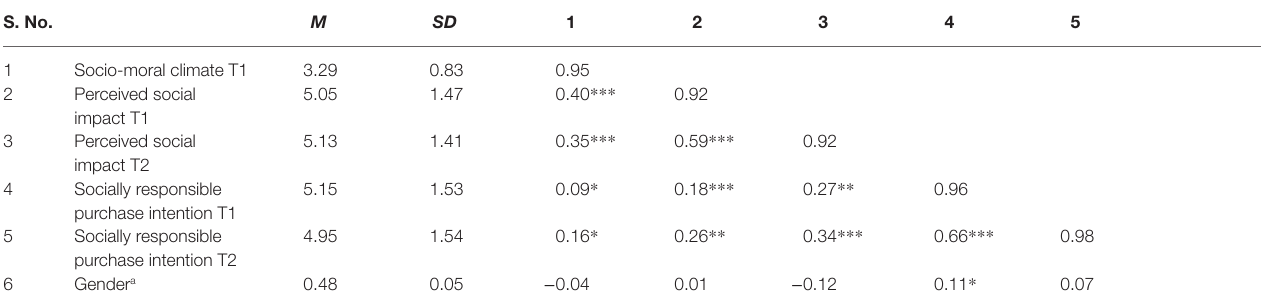
TABLE 1 | Descriptive statistics, reliabilities, and bivariate correlations of the study variables. S. No.